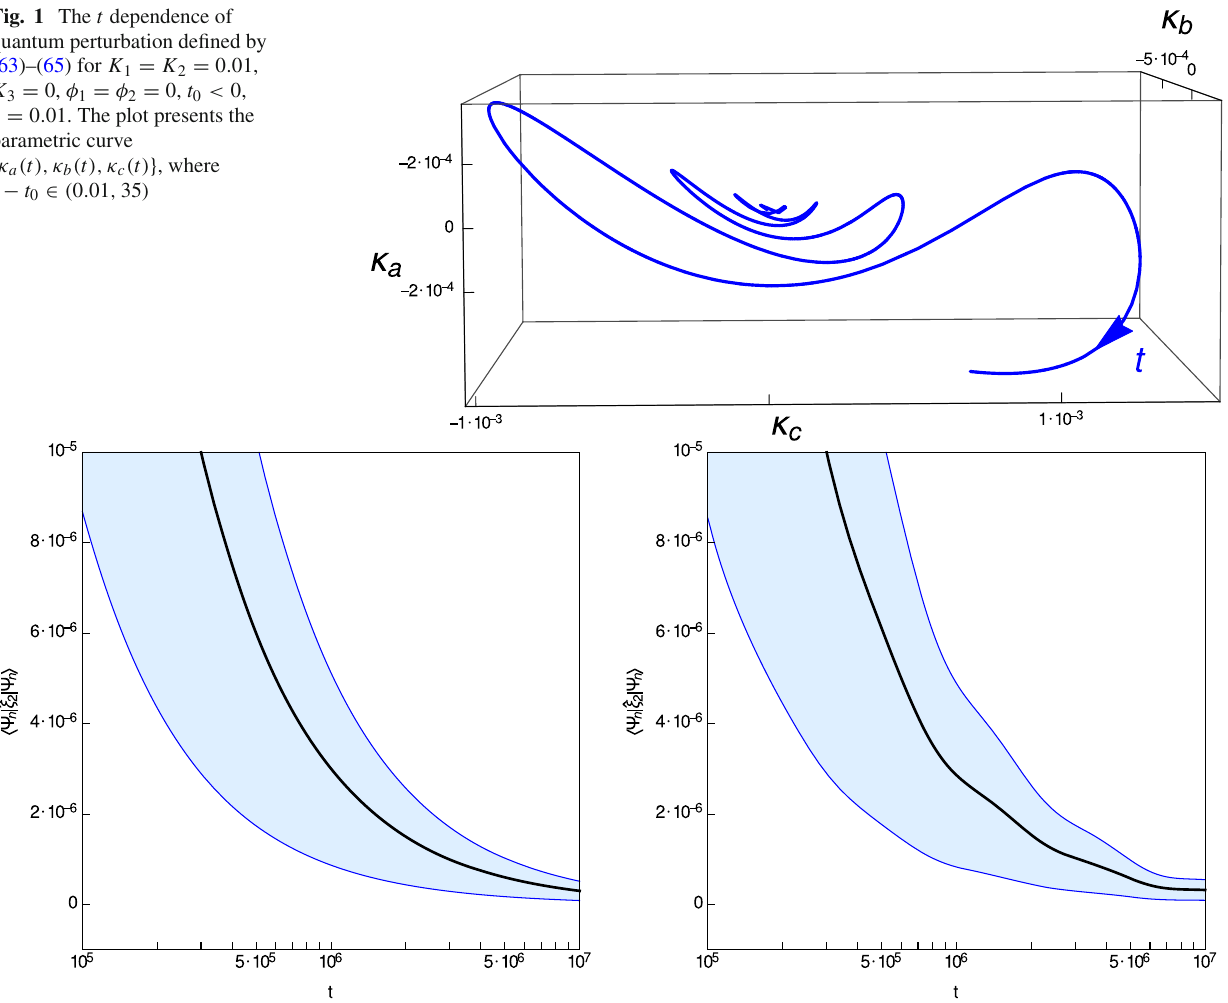
Fig. 1 The t dependence of quantum perturbation defined by (63)–(65) for K 1 = K 2 = 0 . 01, K 3 = 0, φ 1 = φ 2 = 0, t 0 < 0, (cid:3) = 0 . 01. The plot presents the parametric curve { κ ( t ),κ ( t ),κ ( t ) } , where a b c